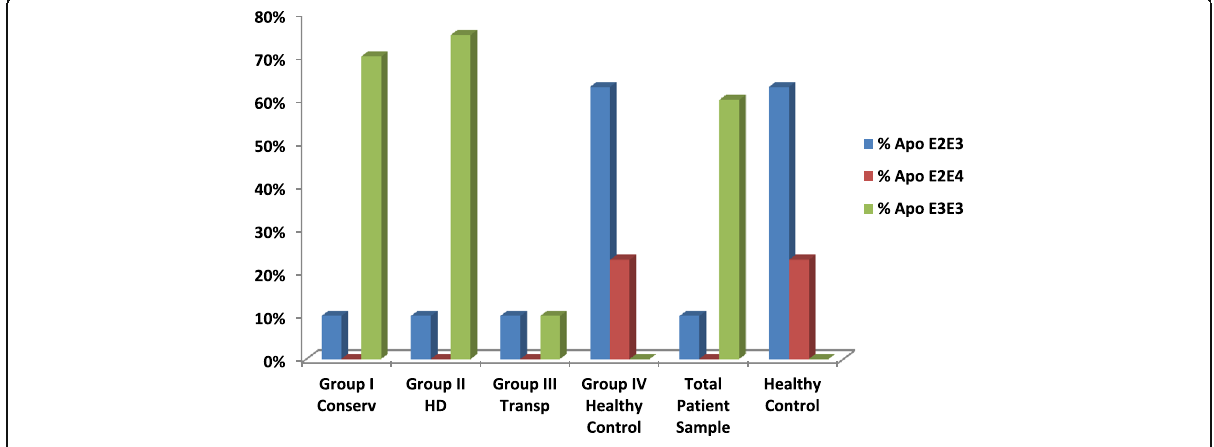
Fig. 5 Frequency distribution of groups according to E3E3 polymorphism